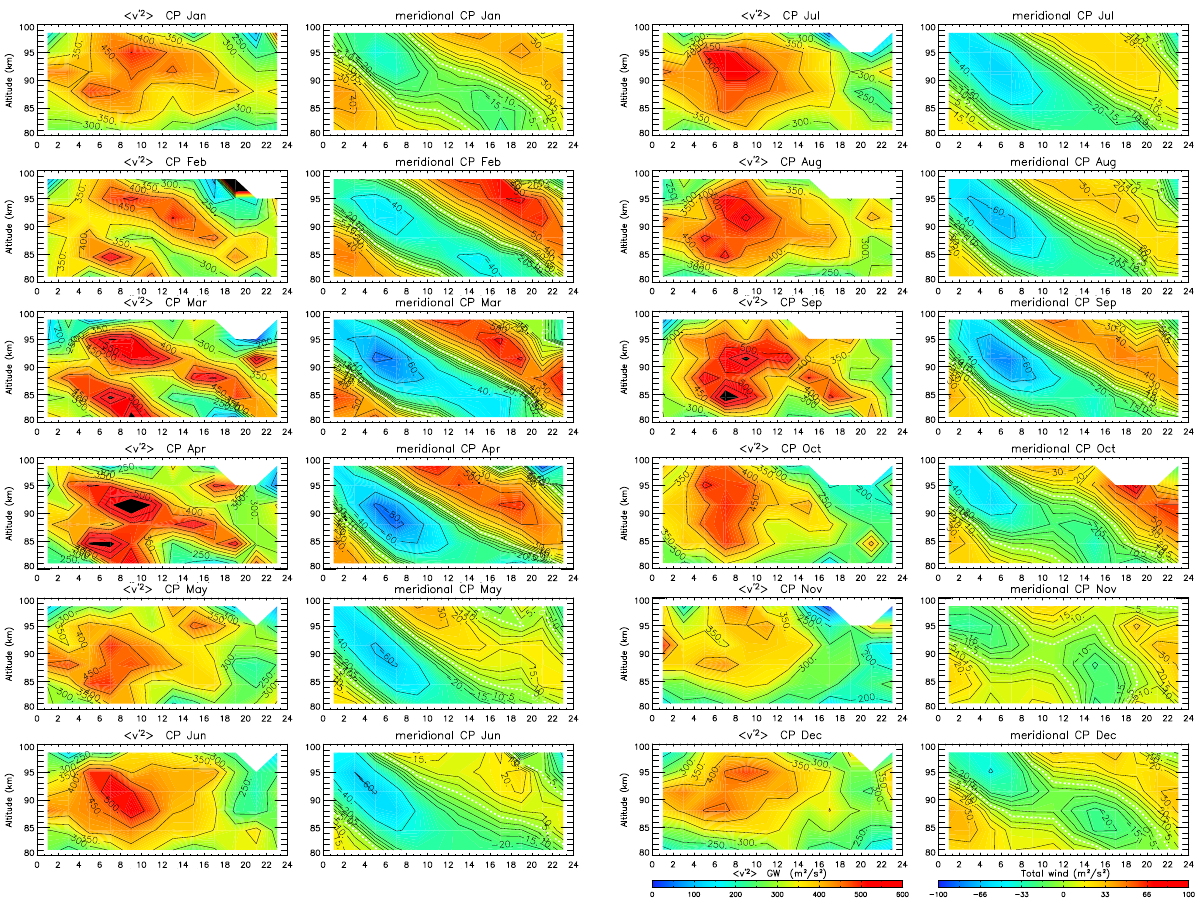
Fig. 8. The same as Fig. 7, but for the meridional